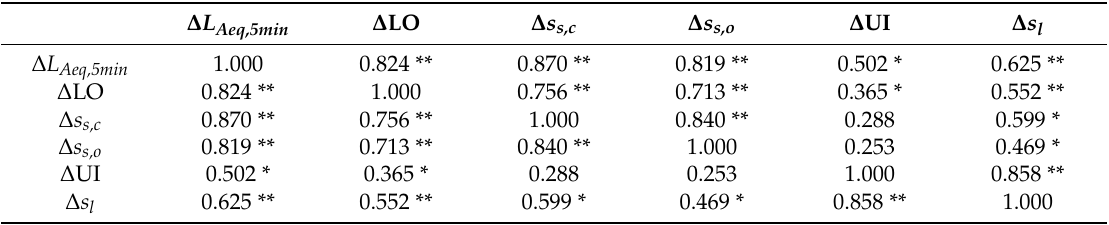
Table 1. Relationship between subjective and objective variations, where Pearson correlation coefficients are shown in each cell.